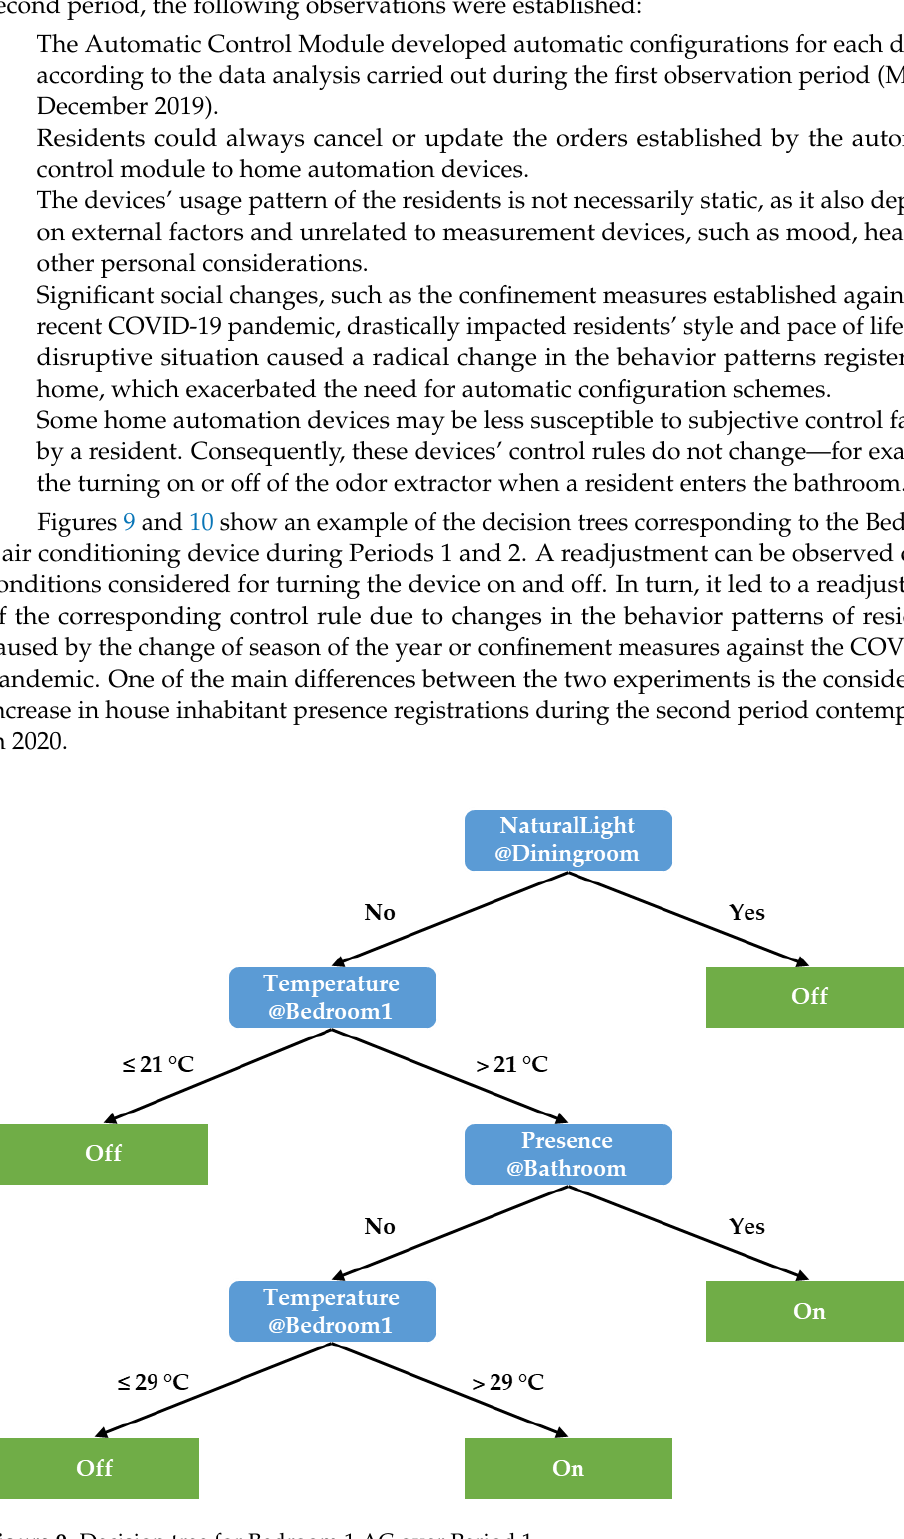
Figure 10. Decision tree for Bedroom 1 AC over Period 2. Figures 11 and 12 show an example of the decision trees corresponding to the Bath- room odor extractor device during Periods 1 and 2, where no changes in the usage pattern were found.